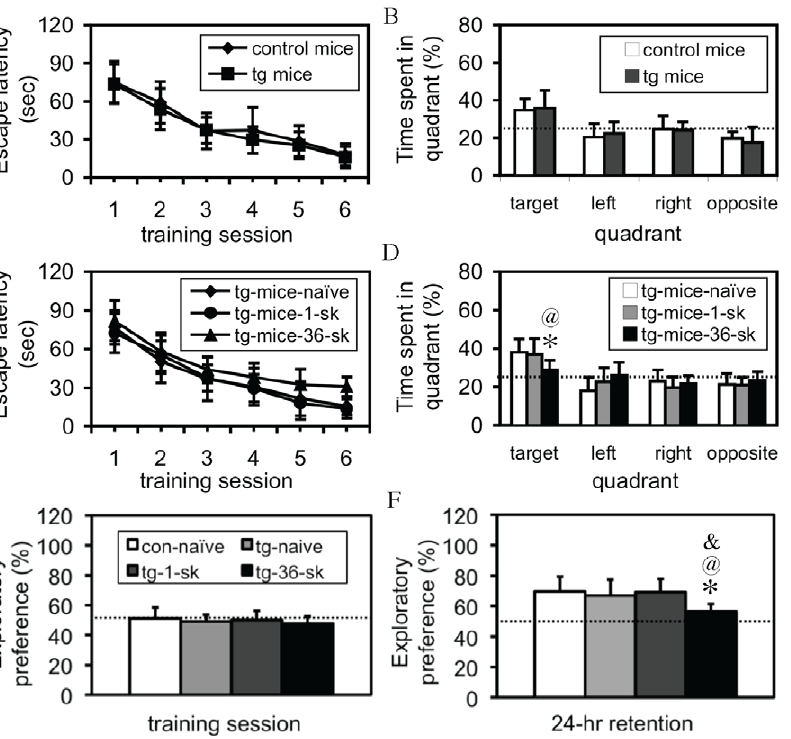
Figure. 5. Impaired hippocampus-dependent memories in tg mice following 36 trials of footshock. (A–D) Spatial learning and memory in the Morris water maze test. (A) Learning curves for both control (n=10) and tg (n=10) mice. Statistical analysis of the escape latency does not show a significant difference between these two groups. (B) A probe test does not reveal a significant difference between these mice either. Dotted line represents the performance at the chance level (25%). (C) Learning curves for tg-naı¨ve (n=8), tg-1-shock (sk; n=11) mice, and tg-36-shock (sk; n =10) mice. A significant interaction between the CCKR-2 transgene and extensive stress is observed in escape latency. (D) A probe test also reveals a significant difference in time spent in the targeting quadrant. Dotted line represents the performance at the chance level (25%). *, p , 0.05, compared to naı¨ve tg mice; @ , p , 0.05, compared to tg-1-shock mice; All are Student’s t tests. Data are expressed as mean 6 SD. (E and F) Recognition memory in the novel object recognition test. (E) Exploratory preference in the training session. There is no significant difference in exploratory preference between these groups. Dotted line represents the performance at chance (50%). (F) Exploratory preference in the retention test. Dotted line represents the performance at chance (50%). *, p , 0.01, compared to naı¨ve control mice (con-naive; n=10); @ , p , 0.05, compared to tg-naı¨ve mice (tg-naı¨ve; n=10); & , p , 0.01, compared to tg-1-shock mice (tg-1-sk; n=8). All are analyzed with a Student’s t test. Data are expressed as mean 6 SD.